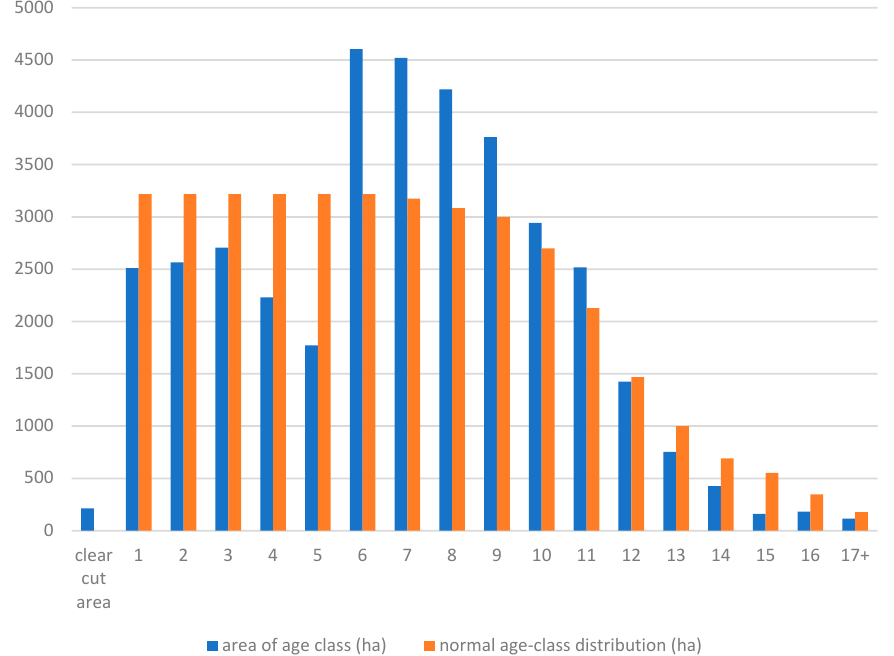
Figure 3. Age structure of forest stands (age classes) in the study area with a comparison of the normally distributed age classes.